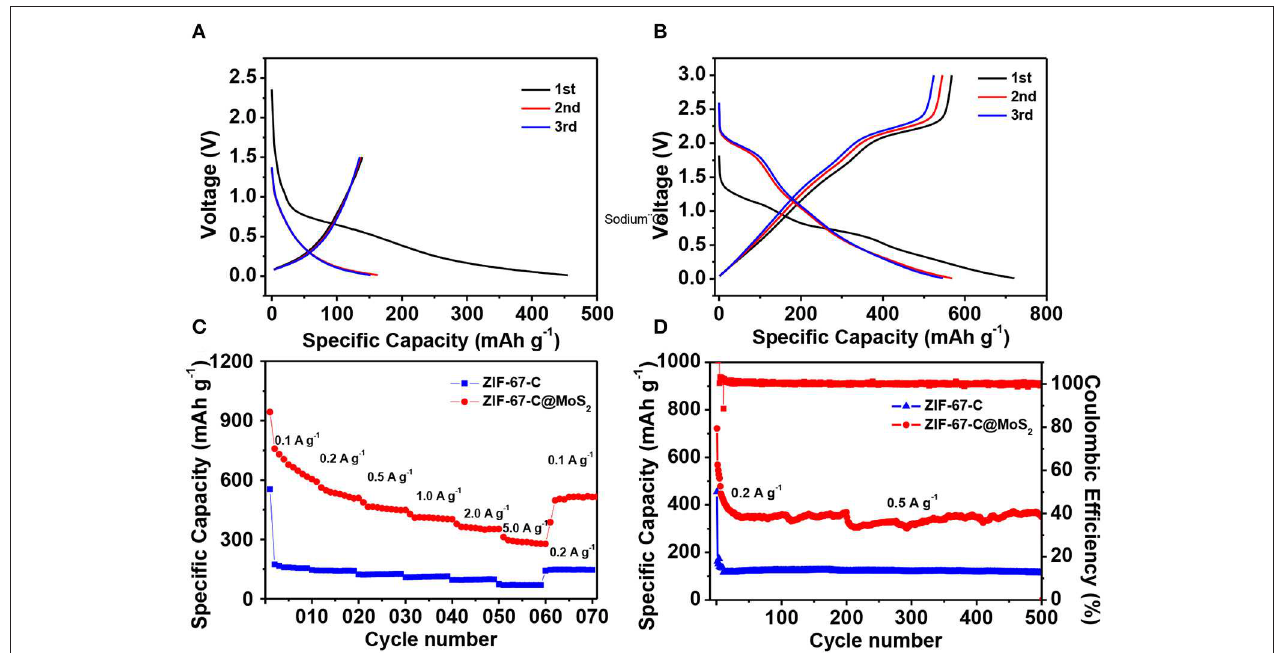
FIGURE 6 | Electrochemical performance of ZIF-67-C and ZIF-67-C@MoS 2 in LIBs. (A) Charge/discharge curves of ZIF-67-C at 0.2A g − 1 in the 1st, 2nd and 3rd cycles in a voltage range of 0.01–1.5V. (B) Charge/discharge curves of ZIF-67-C@MoS 2 at 0.1A g − 1 in the 1st, 2nd, and 3rd cycles between 0.01 and 3V. (C) Rate capability at different rates. (D) Cycling performance of two electrodes at a current density of 0.2 and 0.5A g − 1